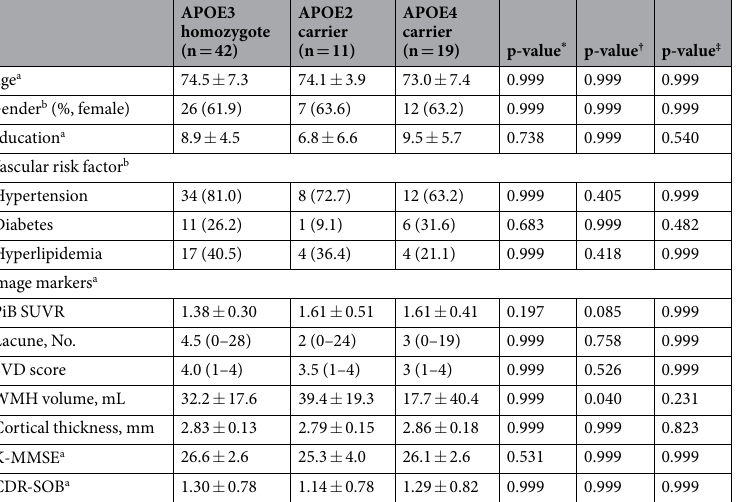
Table 1. Baseline demographic and clinical characteristics. ANOVA test for continuous variables and Chi square test for categorical variables were conducted. To correct for multiple comparisons, we performed Bonferroni post hoc analysis. * Comparison of APOE3 homozygotes vs. APOE2 carriers. † Comparison of APOE3 homozygotes vs. APOE4 carriers. ‡ Comparison of APOE2 vs. APOE4 carriers. a Continuous variables are expressed as mean ± standard deviation or median (minimum-maximum) if not normally distributed. b Categorical variables are expressed as prevalence (%). APOE, apolipoprotein E; PiB = Pittsburgh compound B; SUVR = standardized uptake value ratio; No. = number; SVD = small vessel disease; WMH = white matter hyperintensity; K-MMSE = Korean version of the Mini-Mental State Examination; CDR-SOB = Clinical Dementia Rating-Sum of